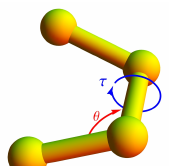
Figure 1. Any two adjacent bonds define a bending angle represented by θ . Four monomers forming three bonds are required to define the torsion angle τ